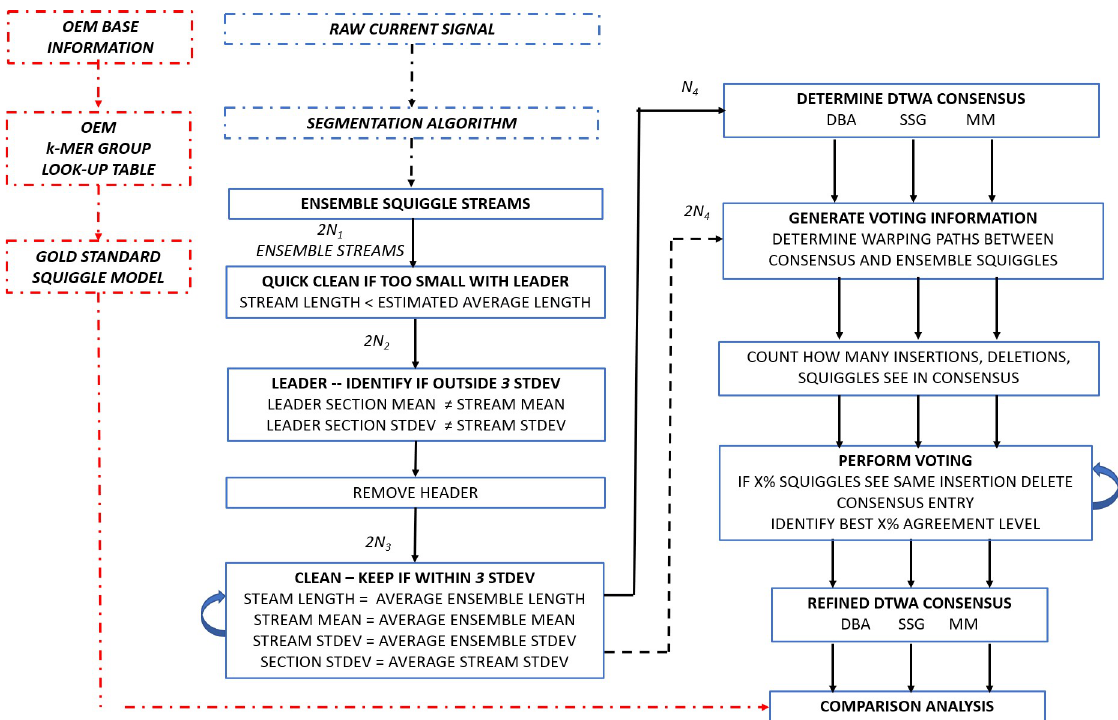
Fig 2. Flow chart representing the process to generate a refined squiggle consensus by applying an ensemble-wide voting scheme to DBA , SSG and MM DTWA generated consensus signals. Each cleaning stage reduces the number of streams. While the consensus is based on DTWA processing of cleaned data streams, the voting scheme can be based on the agreement with additional streams not involved in generating the consensus experimentally available. Gold standard information is used as part of the final comparison analysis and plays no role in squiggle cleaning, consensus generation or the voting procedure.